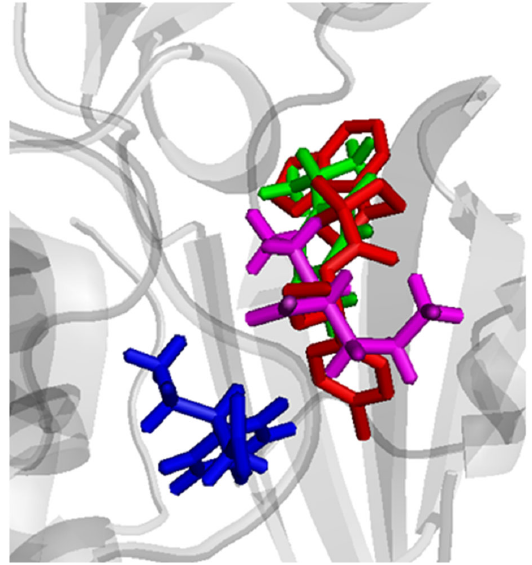
Figure 9. Comparative binding positions of ternary supramolecular complex of the SVP (magenta), BFN (blue) and THQ (green) with the reference crystallized ligand (red) bound to Akt active site. BFN established electrostatic interactions with the key allosteric residue Asp 274 and the active site residue Lys 276 with its ammonium and carboxylate groups, respectively.